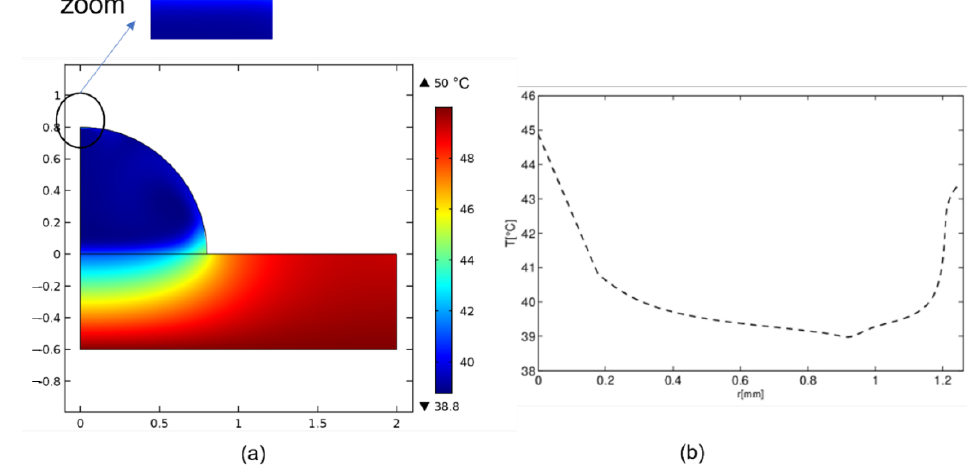
Figure 12. TBH configuration on glass substrate (t = 1 s, θ = 90 ◦ , V 0 = 1 mm 3 , T h = 50 ◦ C, Φ = 3 mW). ( a ) Temperature field, ( b ) temperature along the interface.